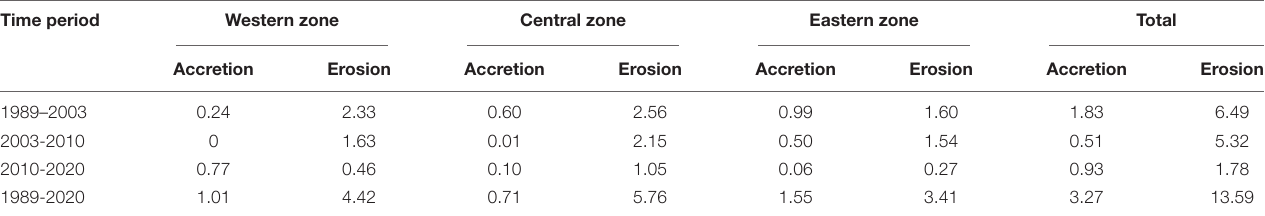
TABLE 1 | Measurements of coastal land area changes by accretion and erosion (in km 2